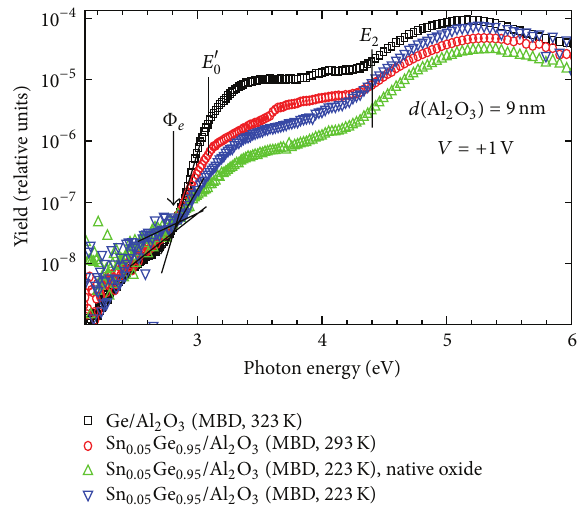
Figure 23: Semilogarithmic plot of the IPE quantum yield as a function of photon energy as measured on (100)Si/Ge/a- Al 2 O 3 (9nm)/Au and (100)Si/Ge/Sn 0.05 Ge 0.95 /a-Al 2 O 3 (9nm)/Au samples prepared by using different alumina growth schemes.